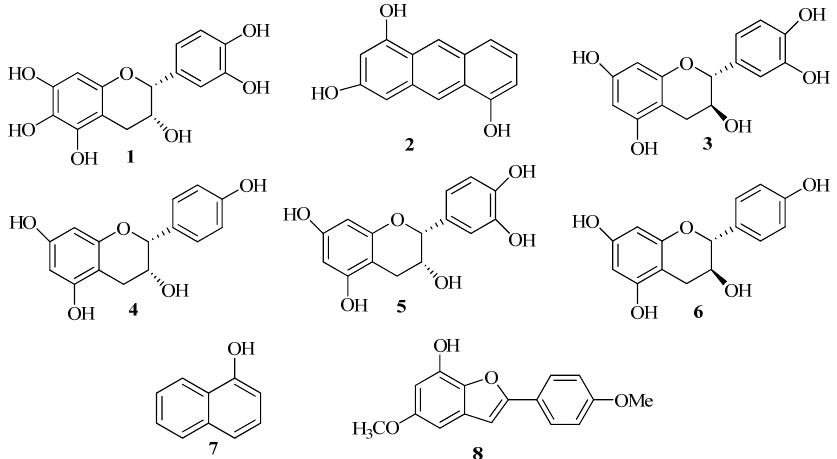
Figure 1. Chemical structures of the phenolics 1 – 8